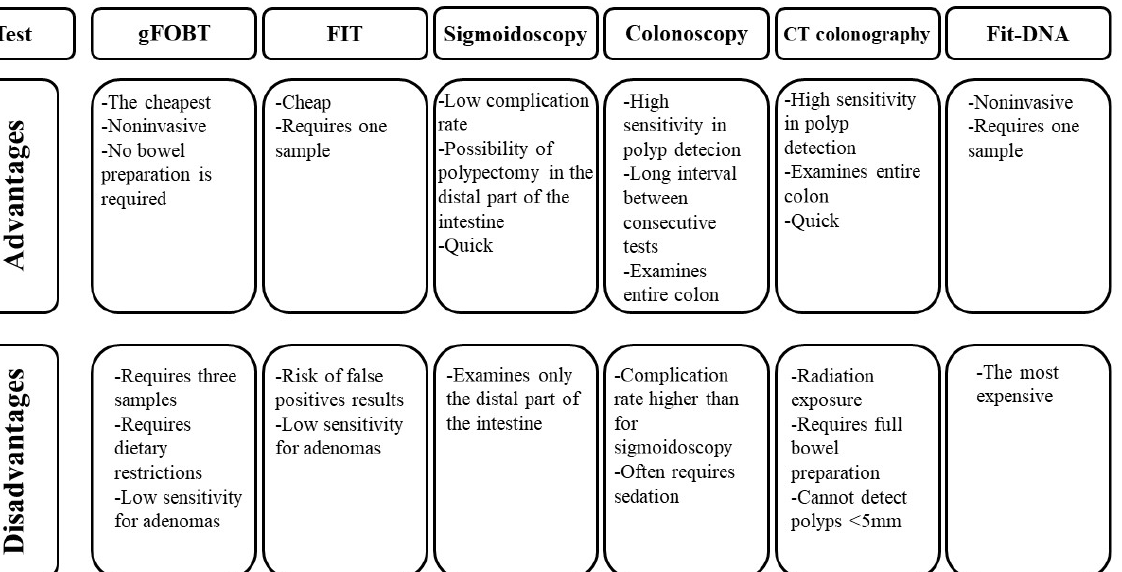
Figure 1. Advantages and disadvantages of selected screening tools in the diagnosis of CRC [24– 28].